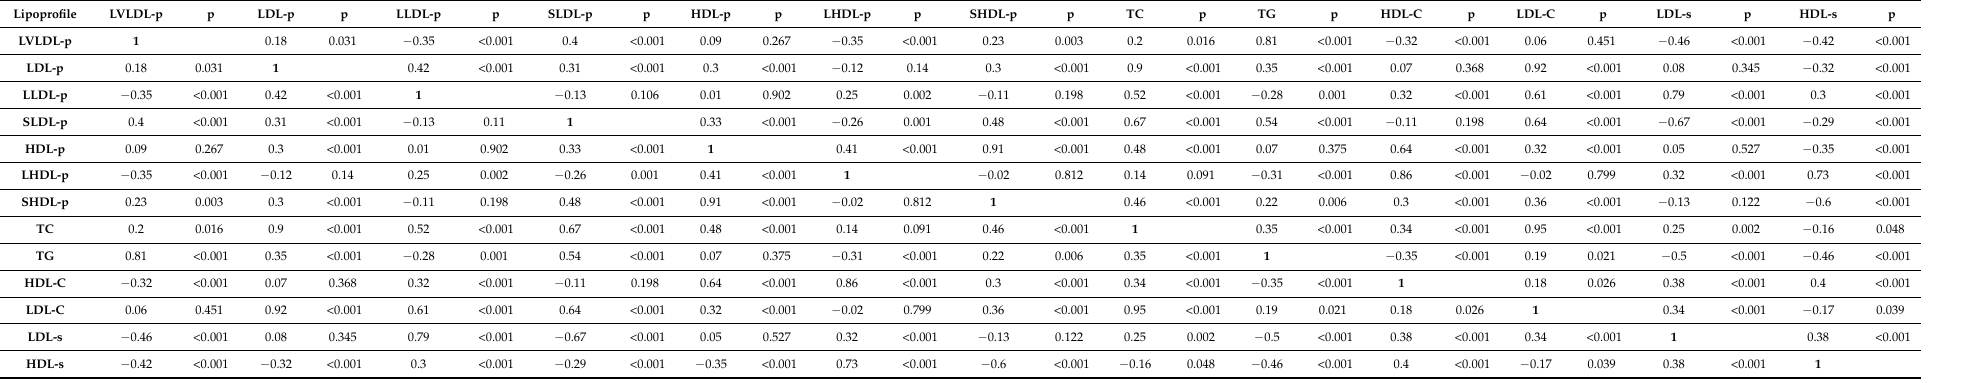
TG = triglycerides). Table 3. Internal correlation matrix among lipids and lipoprotein particles for the lipoprofile